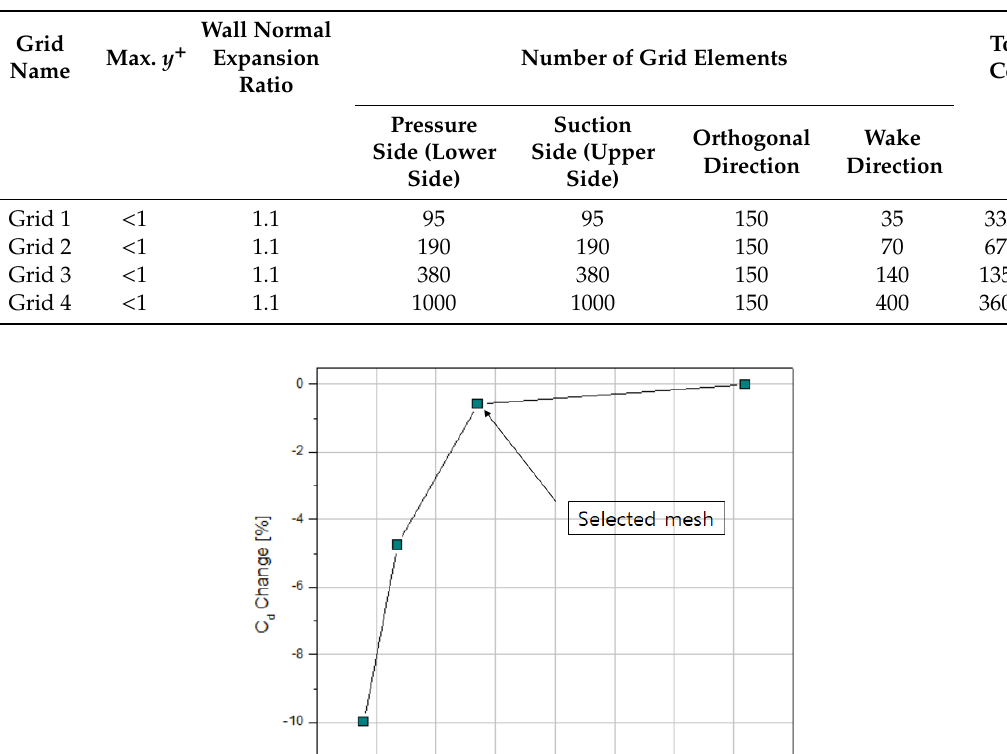
Table 1. Grid independence study.